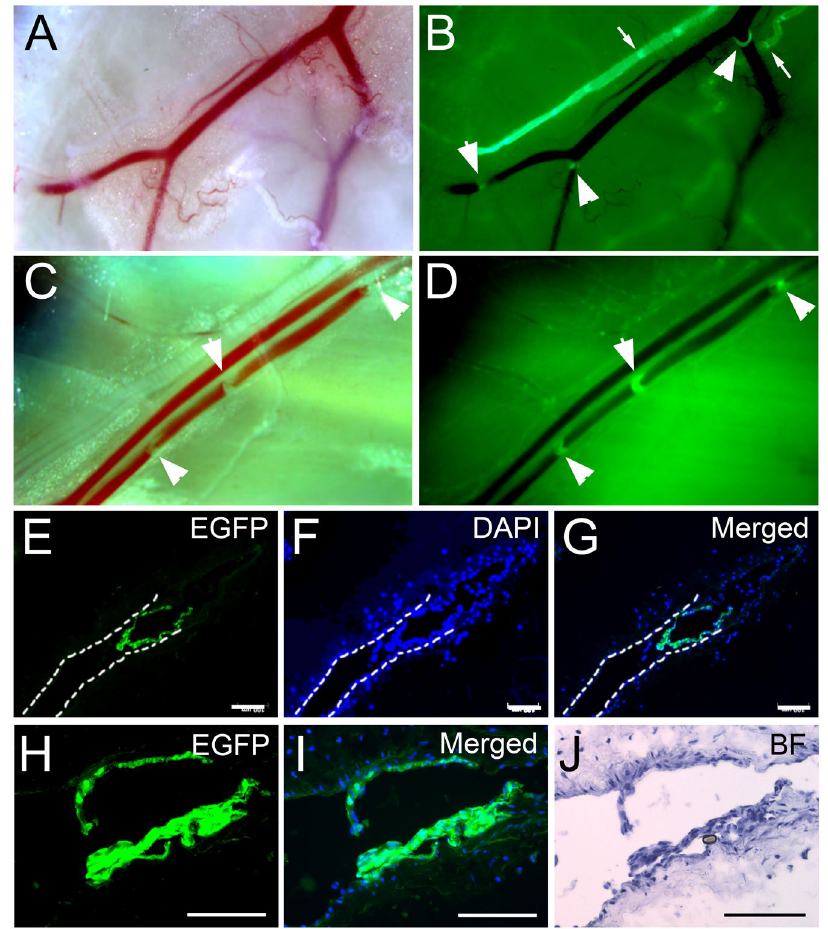
Figure 6. EGFP expression in venous valve endothelial cells of Prox1-EGFP rats. Comparative bright field ( A ) and fluorescent ( B ) images of arterial, venous, and lymphatic vessels of the abdominal wall in Prox1-EGFP adult mice. Blood-filled artery and vein alongside EGFP-positive lymphatic vessels are shown. Note that both venous valves (arrowheads) and lymphatic valves (arrows), along with lymphatic vessels, show strong EGFP expression. Similarly, bright field ( C ) and fluorescence ( D ) analyses revealed strong EGFP-positive valves (arrowheads) in the greater saphenous vein from Prox1-EGFP rats. ( E–G ) A cross-section of the greater saphenous vein showing robust EGFP signals in the closed valves ( E ). DAPI counter staining ( F ) and merged images ( G ) are also shown. ( H–J ) Fluorescent and bright field microscopic images showing EGFP-expressing opened venous valve ( H ), DAPI counter staining ( I ), and a corresponding hematoxylin-stained bright field image ( J